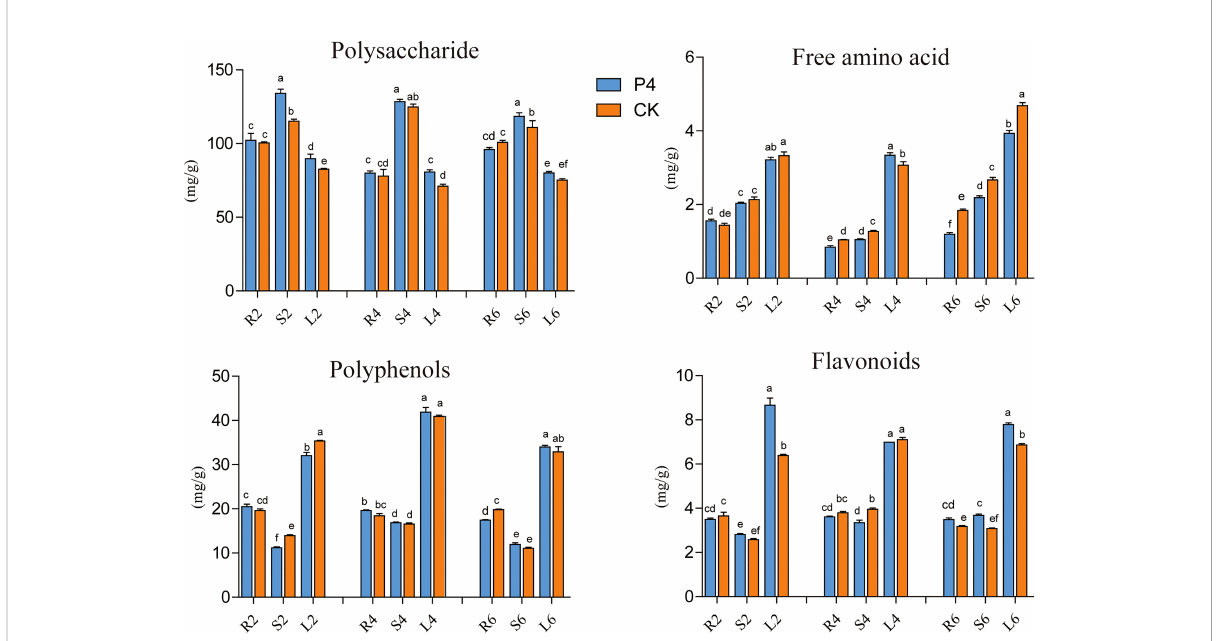
FIGURE 3 Dynamic changes of bioactive compounds in different tissues of A. roxburghii . R, Root, S, Stem, L, Leaf; 2, 4, and 6 represented different months after different treatments. Different letters in columns indicate signi fi cant difference determined by Tukey ’ s test ( p < 0.05; n = 3).